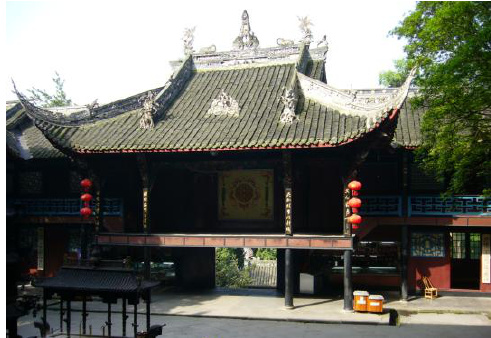
Photo 2.The north facade of the